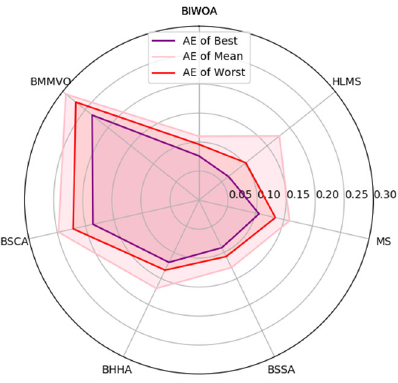
Figure 10. The performance comparison of 7 methods based on AE for Test set IV.